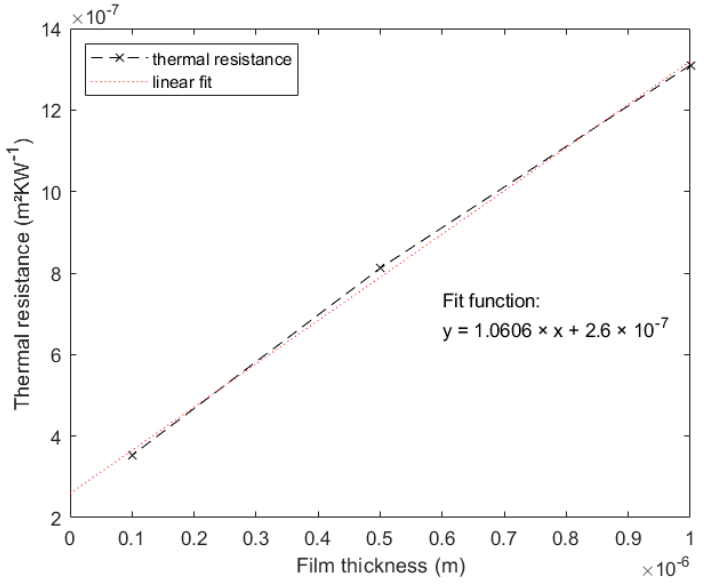
Figure 11. Thermal resistance of SiO 2 thin film for different film thicknesses. A linear fit with the corresponding fit function is displayed, also.